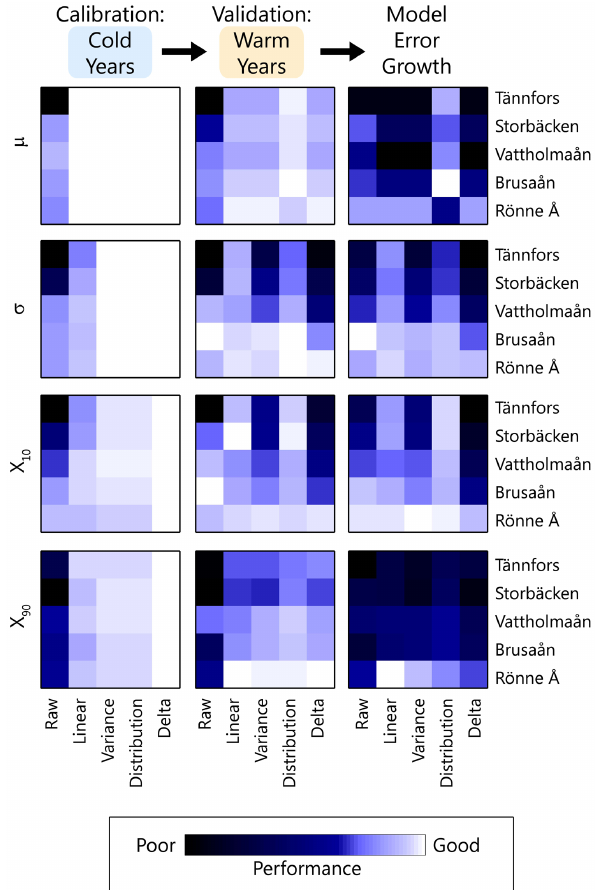
Fig. 7. Normalized temperature model errors (different shades of blue) of 4 different statistical diagnostics (panel rows) for calibra- tion period (left panel column) and validation period (central panel column). The model error growth, i.e., the absolute difference be- tween model errors in validation and calibration period, is shown as well (right panel column). Each panel displays model error infor- mation depending on the 5 applied bias correction methods ( x axis) and the 5 catchment locations ( y axis). The figure is based on case- 1 evaluation with calibration on cold years and validation on warm years.